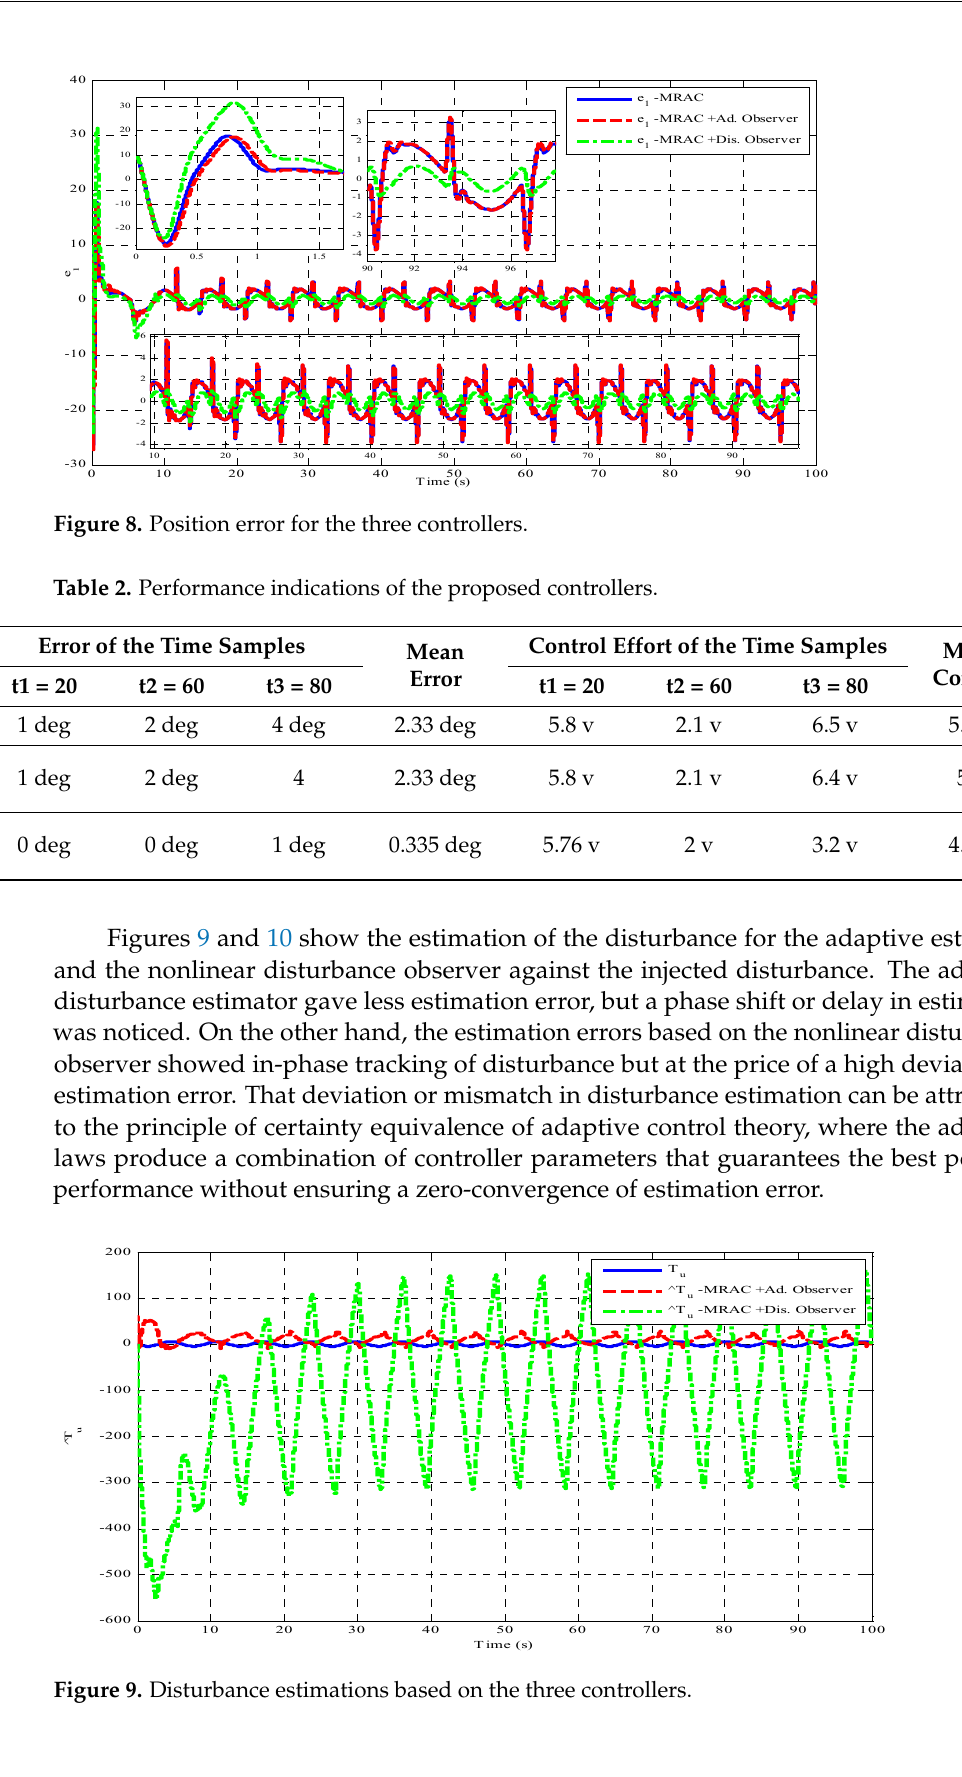
Figure 10. Disturbance versus disturbance estimation by adaptive observer. 5. Conclusions This study presented three controllers based on an MRAC design for trajectory track- ing of the angular position for an exoskeleton knee assistance system. Development of an MRAC controller design, MRAC with an adaptive disturbance estimator, and combining the design of a nonlinear disturbance observer with the MRAC controller to robustly con- trol the angular position of an exoskeleton knee assisted system under unknown and up- per bounded disturbance, has been argued. Making a performance comparison between the proposed three controllers in terms of transient, robustness, and control input charac- teristics, the stability analysis for each scheme was conducted and developed based on the Lyapunov theorem to prove the uniform ultimate bound of tracking and estimation er- rors. In addition, the adaptive laws were developed for the proposed schemes according to the stability analysis. The results based on numerical simulation have shown that the MRAC with a nonlinear observer could give better robustness characteristics and better performance in terms of tracking and estimation errors as compared to the other control- lers. This study can be extended for future work by including other advanced control schemes to the position control of assisting devices to show their effectiveness and perfor- mances as compared to the present controller [35–44]. Author Contributions: Funding, A.S.A.; software and analysis, A.H.H.; Writing and paraphrasing, A.R.A., Conceptualization and methodology, A.J.H.; Funding, A.A.; Reviewing and supervision, A.K.A.M. All authors have read and agreed to the published version of the manuscript. Funding: This research has been funded by authors. Institutional Review Board Statement: Not applicable.